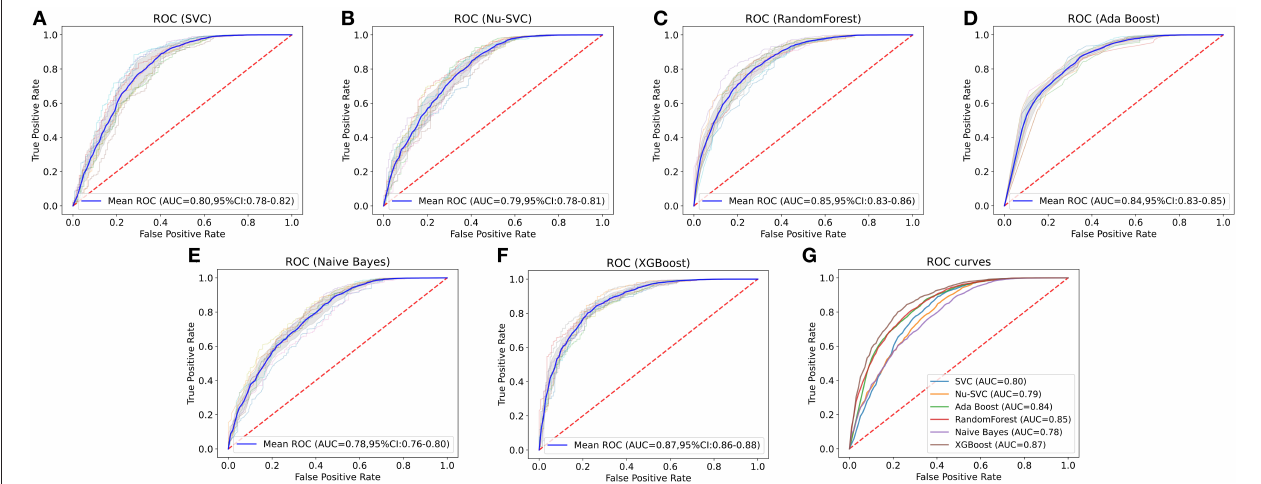
FIGURE 3 | Comparison of the AUCs of six machine learning algorithms. The predictive model using the eXtreme Gradient Boosting (XGBoost) algorithm had the best predictive performance. SVC, C-Support Vector Classification; RF, random forest; NB, Naive Bayes.